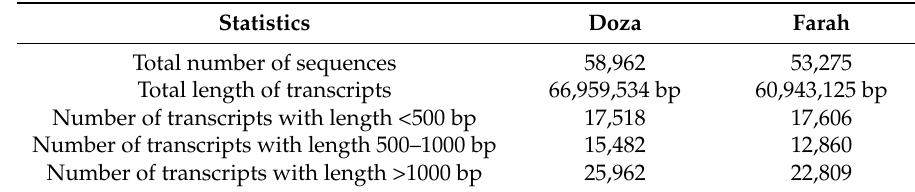
Table 4. Statistics of the filtered Doza and Farah